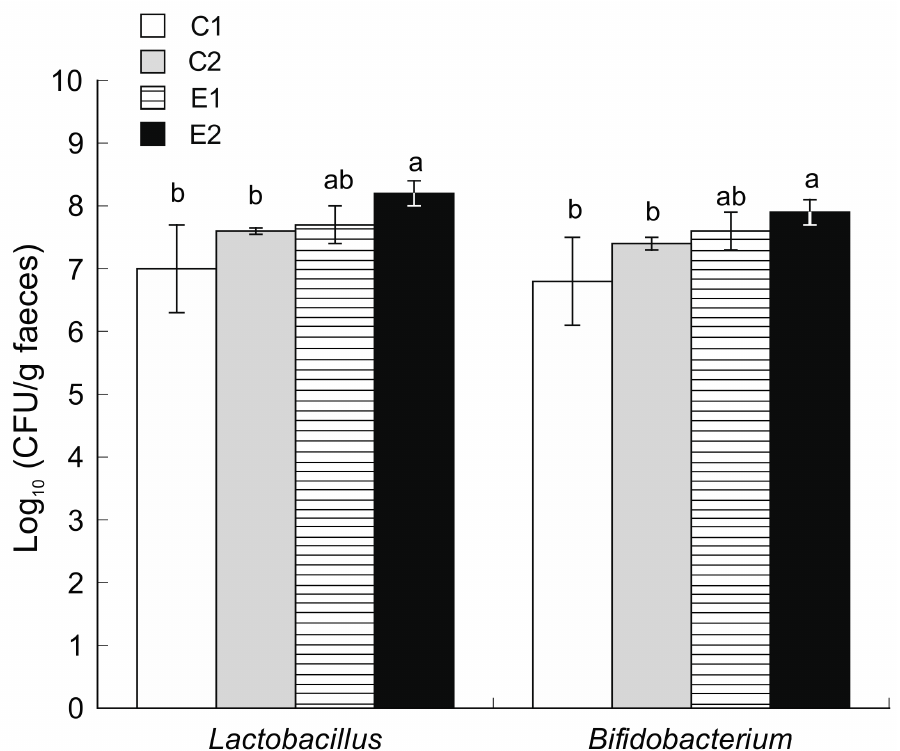
Figure 4. Microbial counts of Lactobacillus and Bifidobacterium in caecum faecal samples obtained after sacrifice (mean and SD, n = 12). C1 wild-type mice fed a standard diet, C2 Apc Min/+ fed a standard diet, E1 Apc Min/+ fed a standard diet supplemented with microencapsulated Bf and Lg, E2 Apc Min/+ fed a standard diet supplemented with microencapsulated Bf , Lg and quercetin. Bars with different letters indicate statistically significant differences ( p < 0.05; one-way ANOVA was used followed by Tukey’s post hoc test).